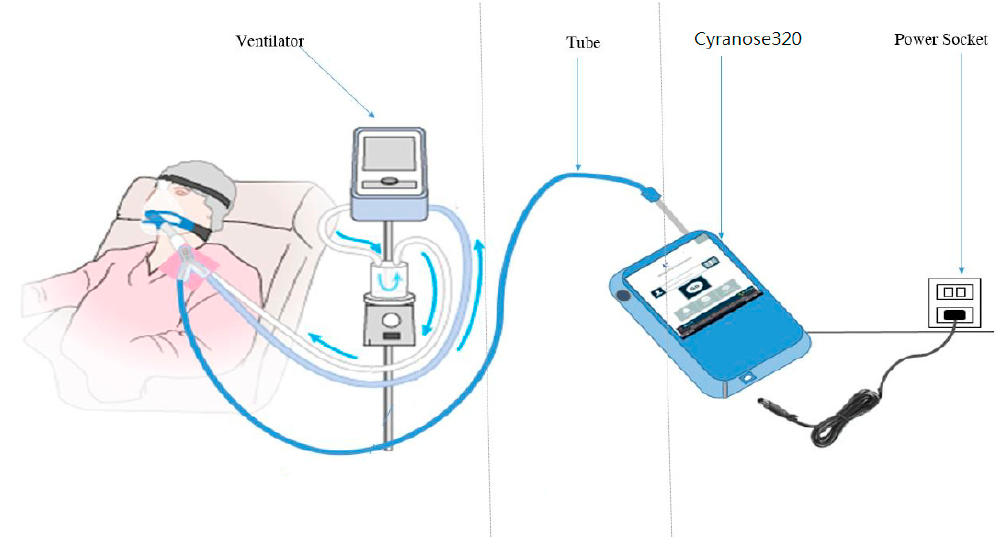
Figure 1. Breath gases collection in ICU (intensive care unit).